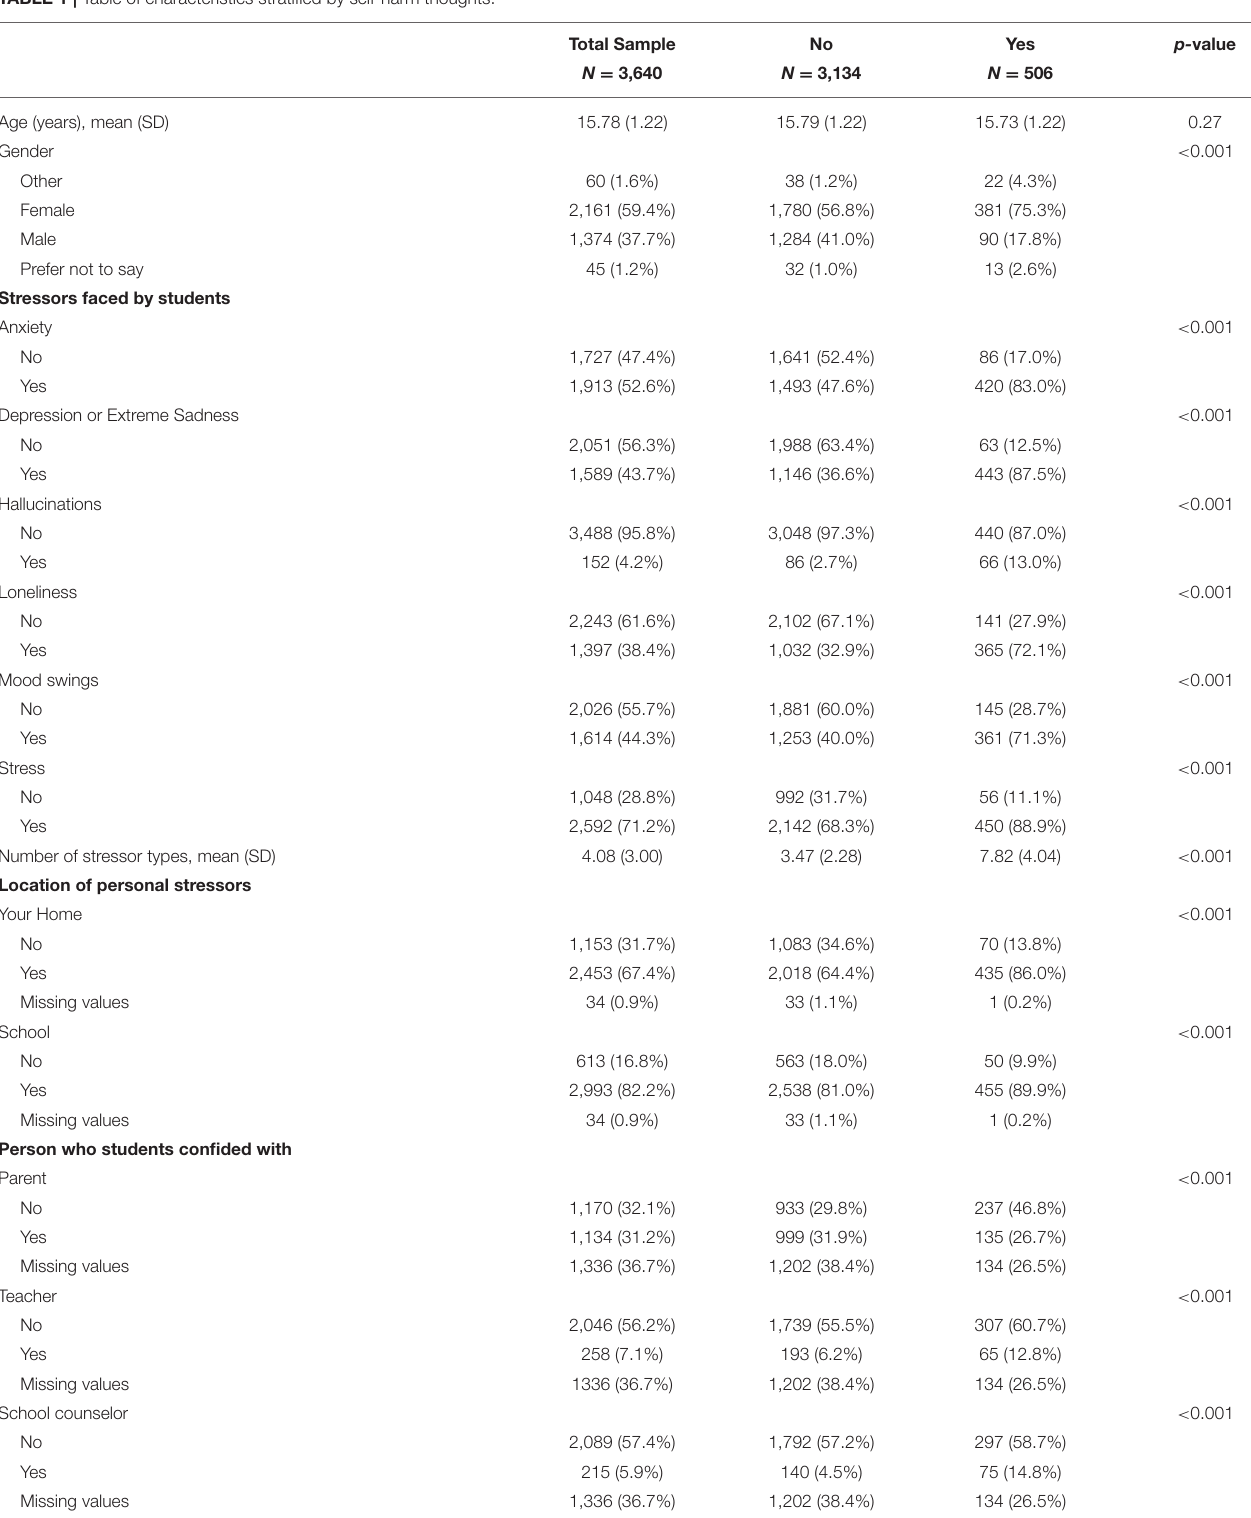
TABLE 1 | Table of characteristics stratified by self-harm